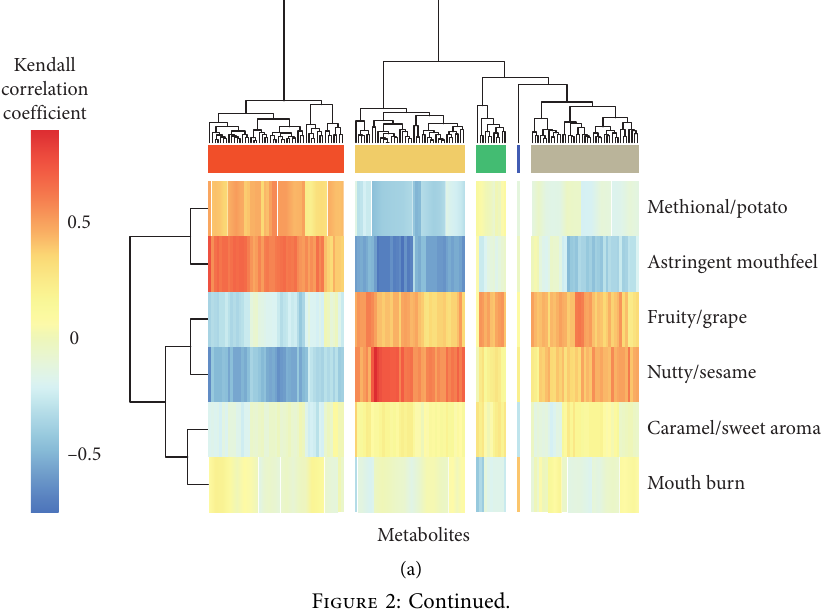
Figure 1: (a–d) Volcano plots of analytes in SS samples stored for eight months at 30 ° C. Each dot within the graph represents a unique analyte. The x -axis units are the log2-fold changes of the molecular abundances of the aged samples relative to the control t � 0 sample. The y - axis units are the negative log of p values comparing the concentrations of the denoted analyte to that of the control. When there were significant differences between the abundances of the analyte compared with the control, meaning a p value less than 0.05, the analyte was denoted with a blue dot; gray dots denote analytes not significantly different in abundance from the control. Thus, as storage time increased from two to eight months, the number of blue analytes